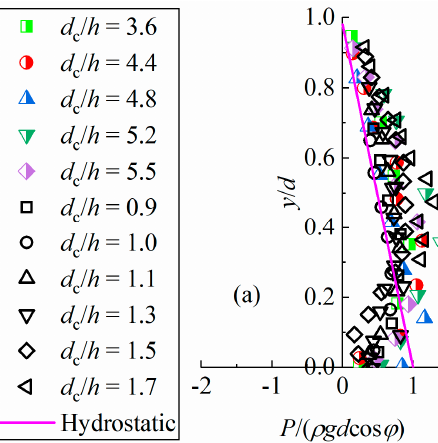
Figure 6. Flow pressure distribution along step surfaces at step no. 43 (dc/h = 4.8): ( a ) horizontal and ( b ) vertical. On the step surfaces, the min. and max. pressures, denoted as P min and P max , provide insight into cavitation status and hydraulic loads. The extreme pressure P e (or P min and P max ) is associated with the flow condition ( q ), step geometry ( h , l , and θ ), flow property ( ρ ), and gravity ( g ). Therefore, these parameters are selected to describe P e